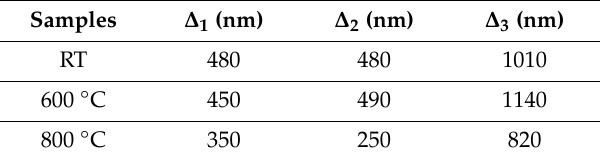
Figure 7. Nano-scratch test with scratch track at 400 mN of the peak load taken on the pristine surface of the sample tested at 800 ◦ C in sliding test. Table 3. ∆ 1 , ∆ 2 and ∆ 3 values obtained after sliding and nano-scratch